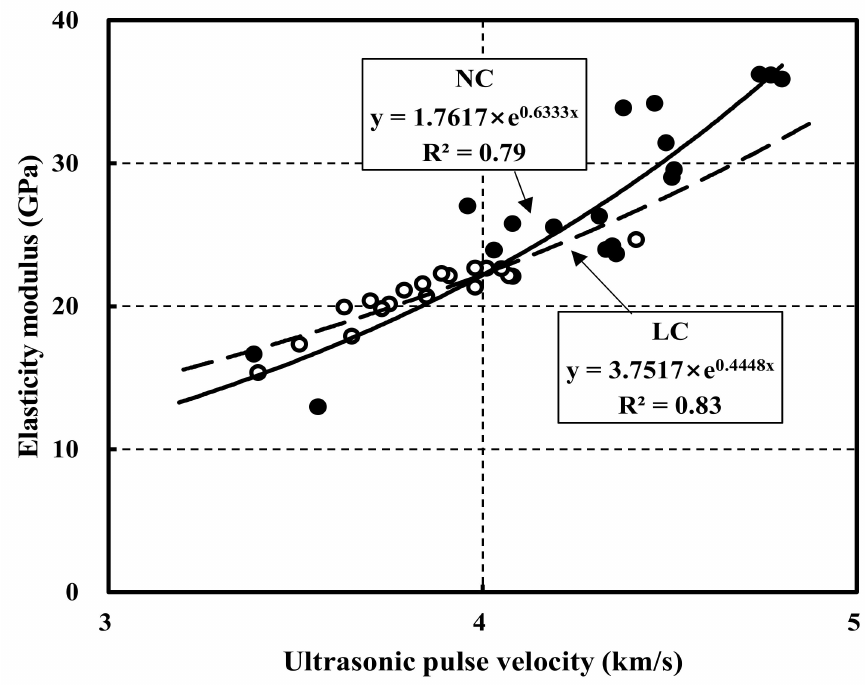
Figure 9. Relationship between elastic modulus and ultrasonic pulse velocity in estimation equation.